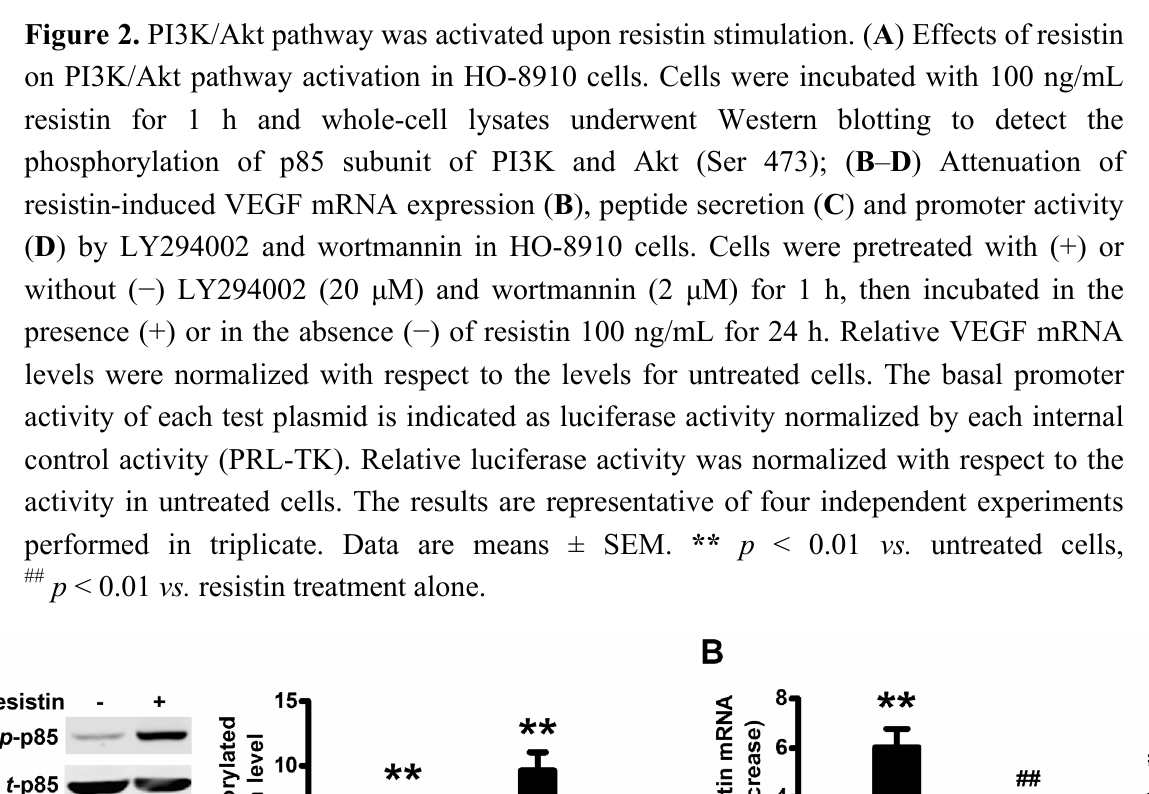
Figure 2. PI3K/Akt pathway was activated upon resistin stimulation. ( A ) Effects of